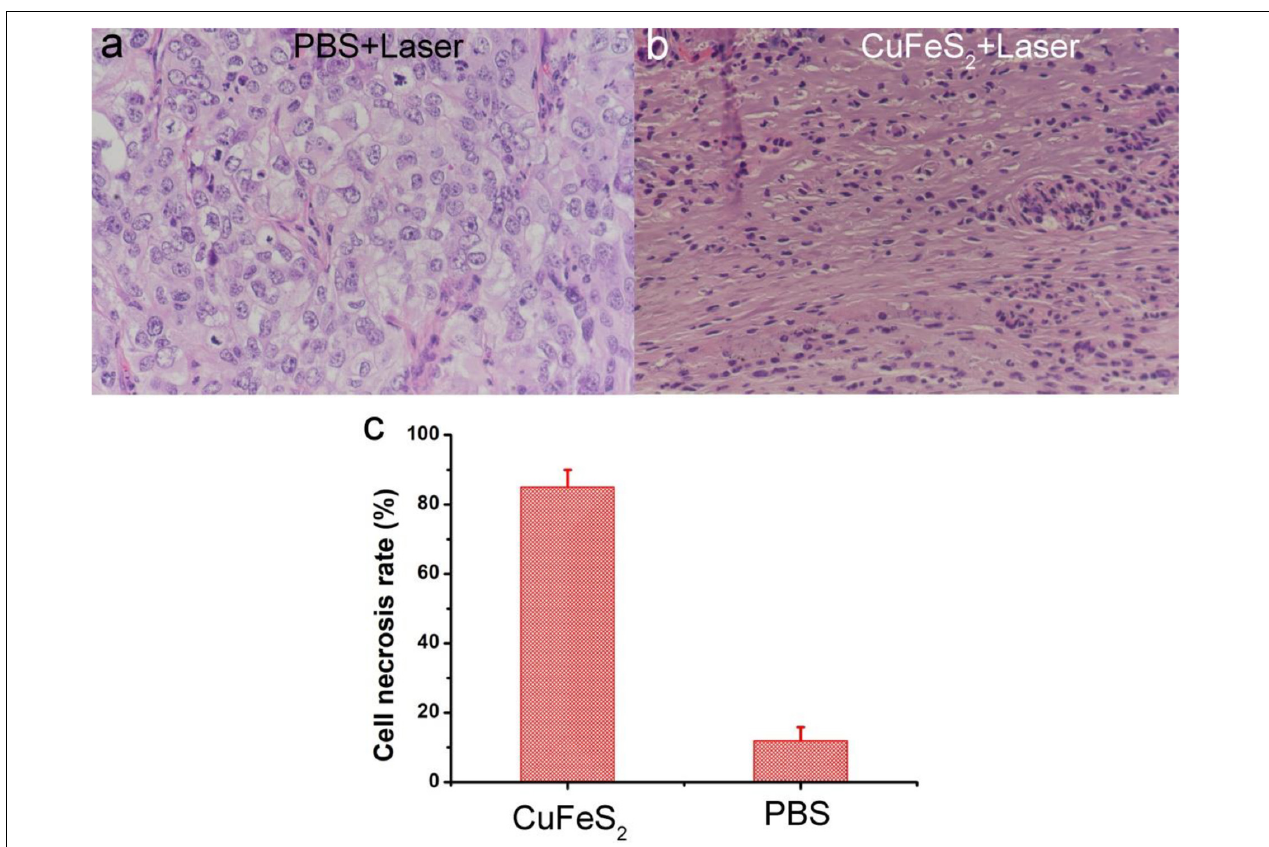
FIGURE 7 | Photographs of hematoxylin and eosin (H&E)-stained tumor slices (a) Tumor treated with PBS and laser irradiation and (b) Tumor treated with CuFeS 2 nanoassemblies and laser irradiation. (c) The cell necrosis rate of the treated